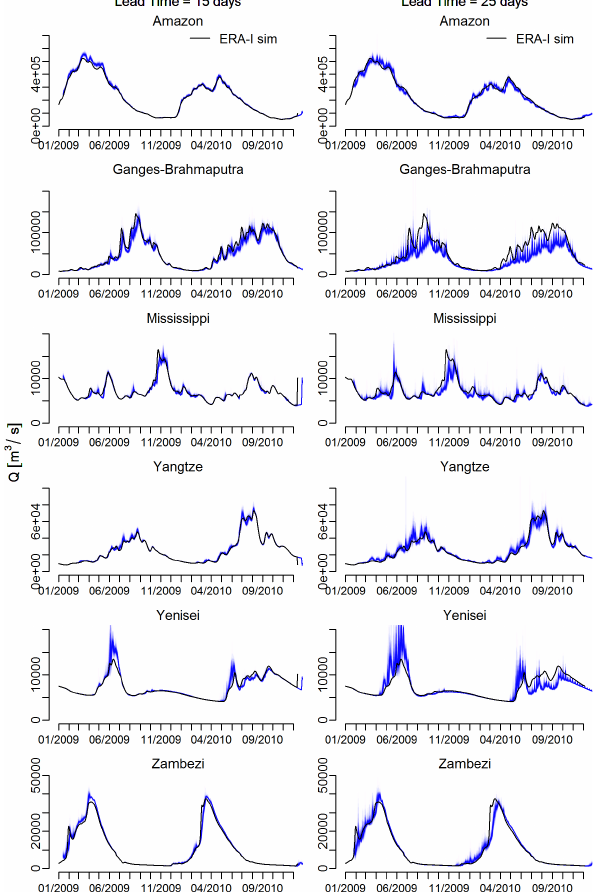
Fig. 9. ESPs (blue shades) and corrected discharge climatology (ERA-I sim) at the outlet of six major river basins (see red mark- ers in Fig. 8), for lead time of 15 (left column) and 25 days (right column).